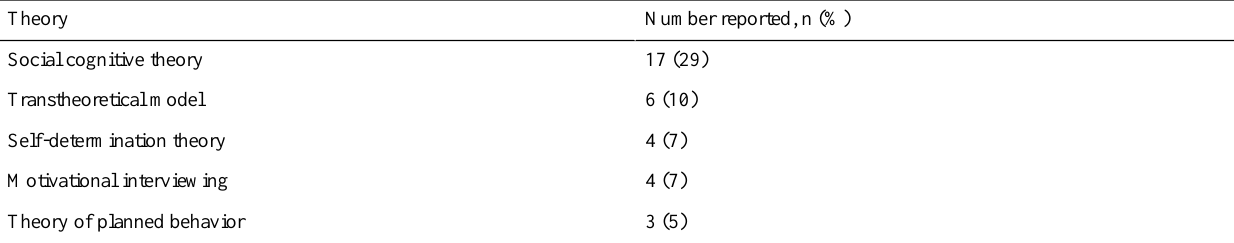
Table 8. Percentage of reported theories